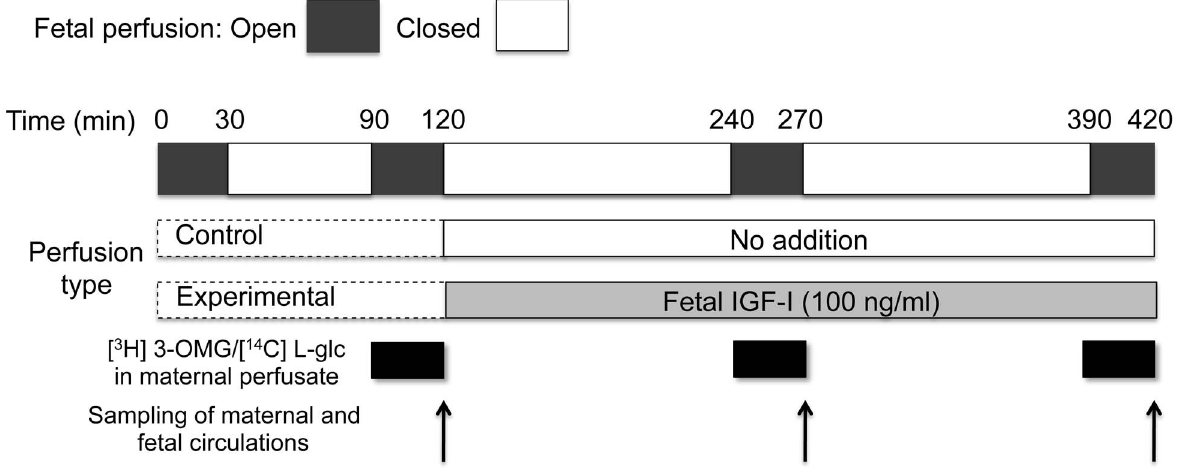
Figure 4. Timeline of control and experimental perfusions. A stabilization phase of 30 minutes (open fetal circulation) and 60 minutes (closed fetal circulation) was used in both control and experimental perfusions. Maternal perfusion was started 30 min after the beginning of the fetal circulation. Between 90 and 120 min the intervillous space was perfused with medium containing [ 3 H] 3-O-methyl-D-glucose and [ 14 C] L-glucose (0.064 and 0.032 m Ci/ml, respectively) to establish rates of transfer from the maternal to fetal circulation (open fetal circulation). After the initial sampling from the maternal and fetal circulations, the fetal circulation was closed and perfusion was continued for 2 hours. During this period, the fetal perfusate in the experimental perfusions contained IGF-I (100 ng/mL) whereas the control perfusions contained no addition. After another 30- minute phase of perfusion with radiolabeled glucose on the maternal side and open circulation on the fetal side, samples were obtained from both circulations. The fetal circulation was again closed and perfusion was continued for another 2 hours containing IGF-I (experimental) or no addition (control). After a final 30 minute period of perfusion with radiolabeled glucose, perfusions were terminated following the final sampling from fetal and maternal